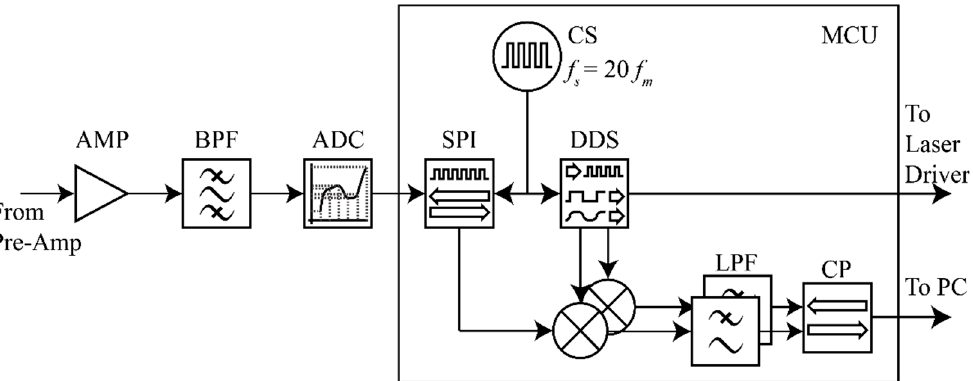
Figure 2. Digital lock-in amplifier to process the signal from pre-amplifier and offer modulation output to the laser driver. AMP: 4-stage amplifier; BPF: Band-pass filter; ADC: analog-to-digital converter; SPI: Serial Peripheral Interface; DDS: Direct digital synthesize; LPF: low-pass filter; and CP: calibration module and communication serial port.